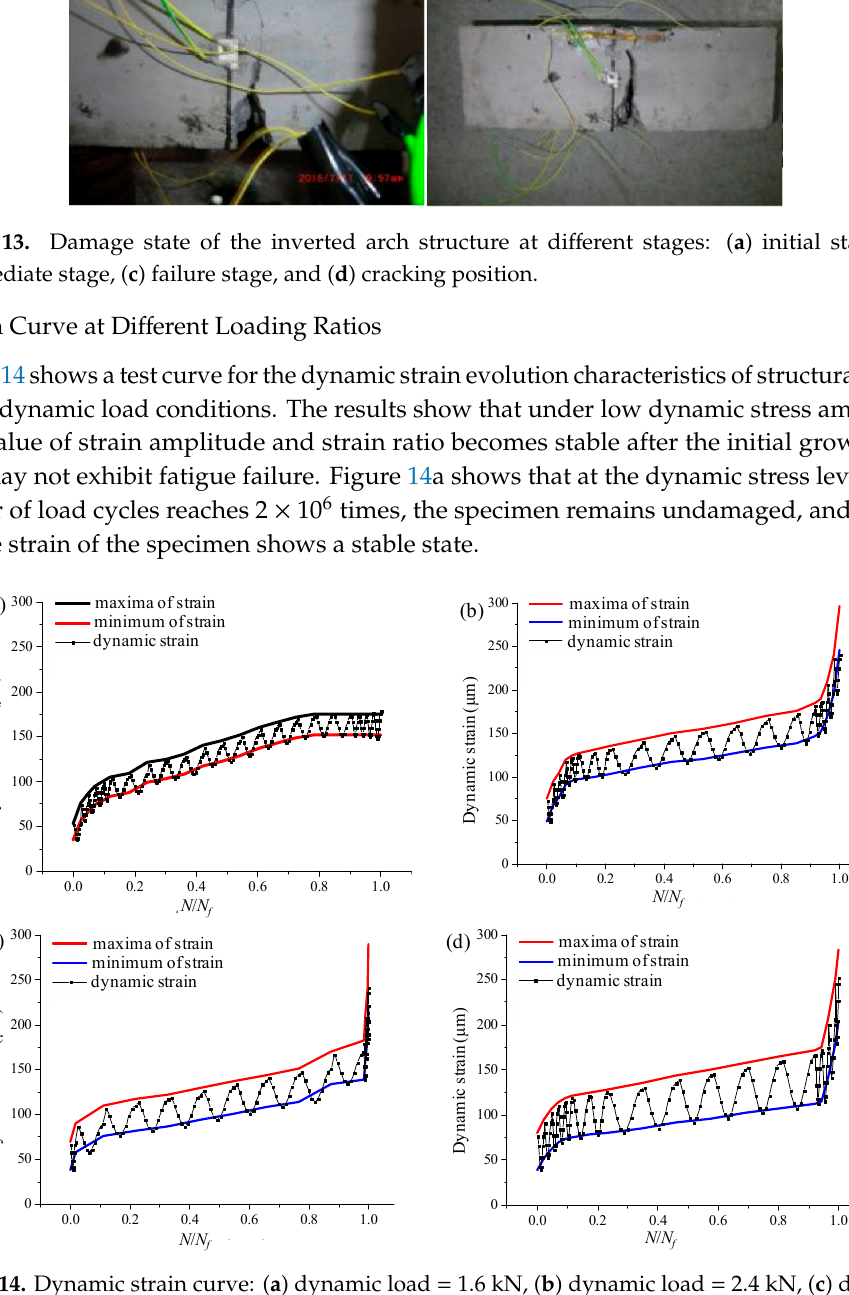
Figure 14. Dynamic strain curve: ( a ) dynamic load = 1.6 kN, ( b ) dynamic load = 2.4 kN, ( c ) dynamic load = 3.6 kN, and ( d ) dynamic load = 4.5 kN.